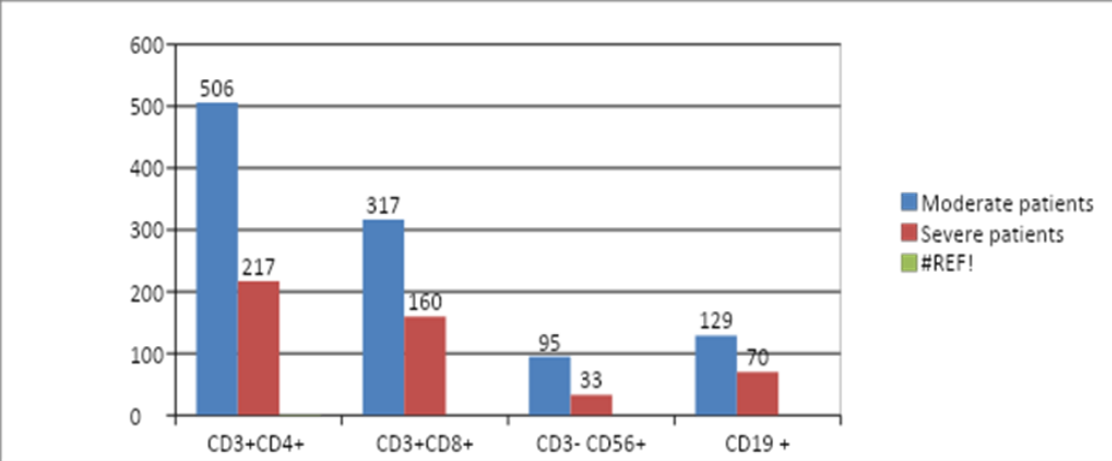
Figure 2. Comparison of median of different lymphocyte cells’ count among COVID-19 patients according to disease severity (cells/uL).